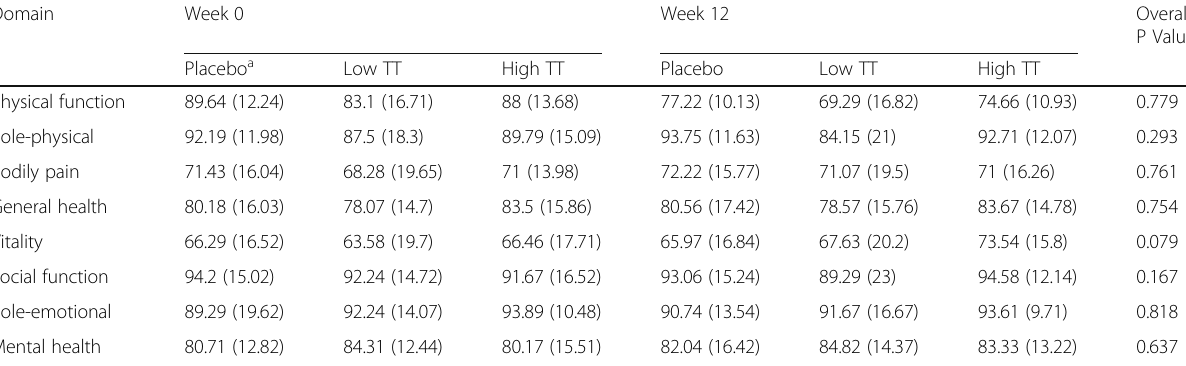
Table 4 Effect of tocotrienol supplementation on quality of life in postmenopausal osteopenic women Domain